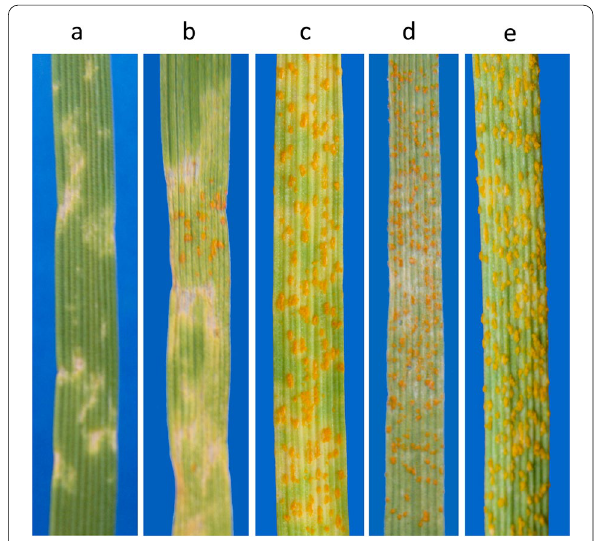
Fig. 2 Mingxian 169 wheat leaves with various infection types (ITs) after inoculation with grass urediospores. a IT (isolate 3-28-7 listed in Table 4. d IT Table 4. e IT 4 (isolate 13-38-3 listed in Table 4) =